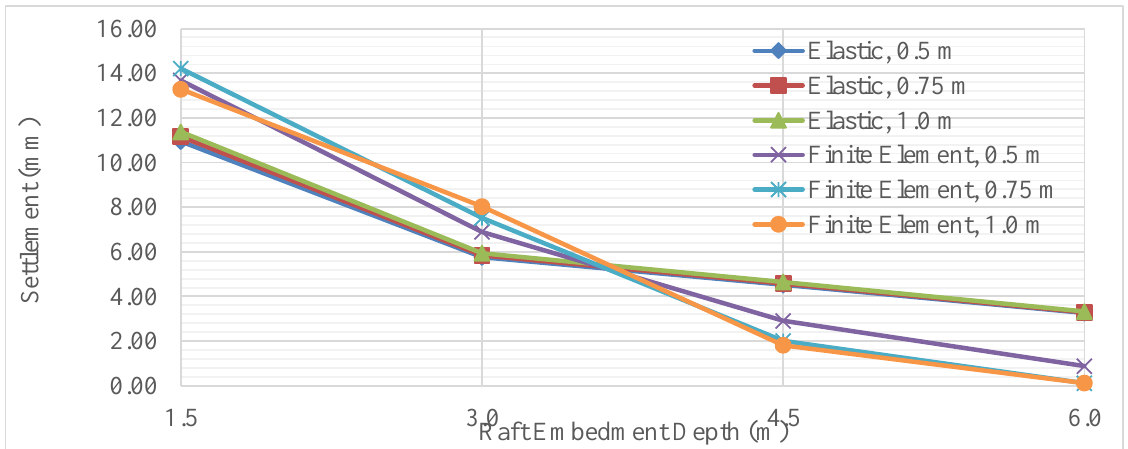
Fig. 10. Settlement versus depth showing the effect of raft thickness for 50 kN/m 2 .